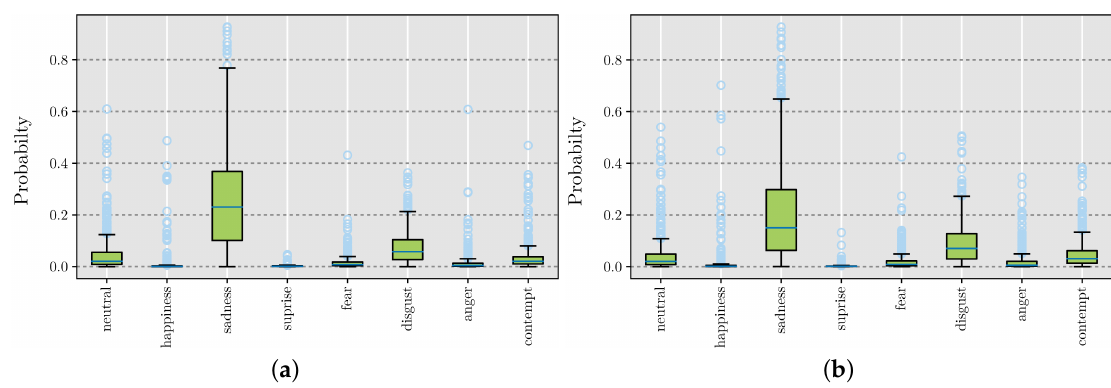
in Figure 14a: fear, happiness, disgust, pulse, and GSR; in Figure 14b: neutral and happiness; in Figure 14c: GSR, happiness, and disgust; in Figure 14d: disgust and